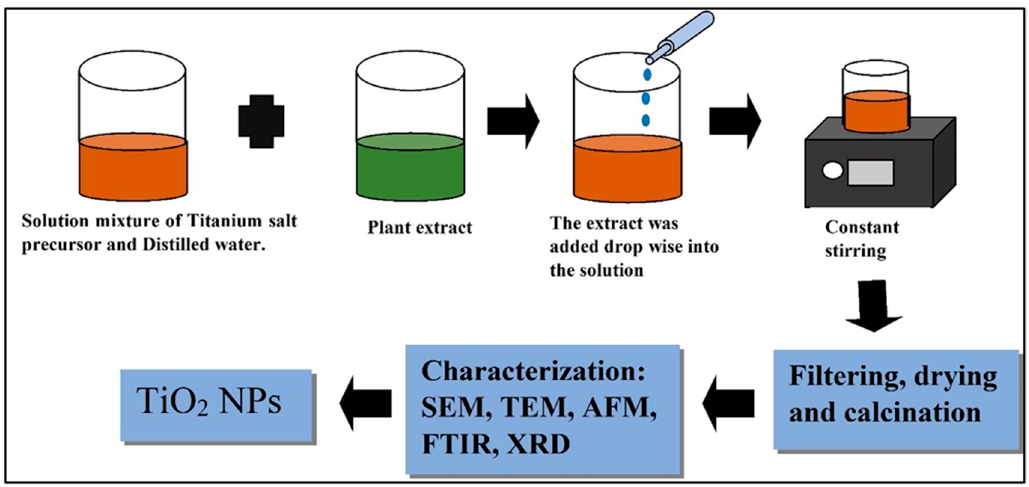
Figure 4. Schematic diagram of the synthesis process of TiO 2 NPs using microorganisms.